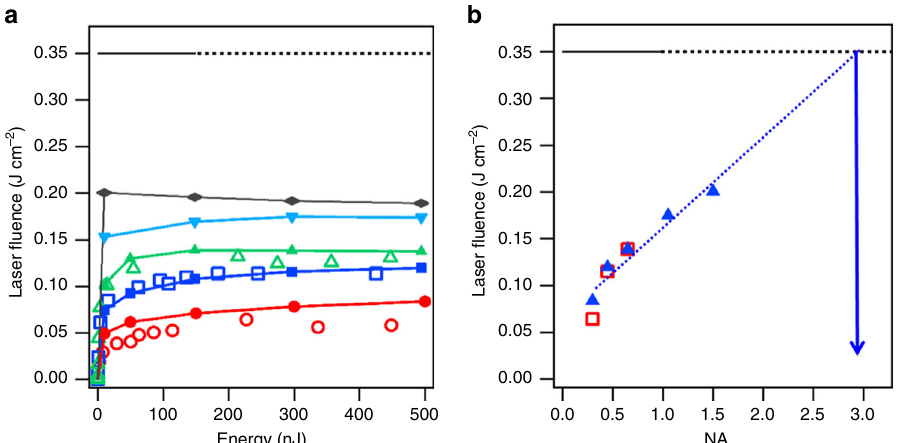
Fig. 2 Maximum delivered laser fl uences inside silicon with ultrashort pulses. Measurements ( hollow symbols ) and simulations ( solid symbols ) for evaluating the peak fl uence delivered with 60-fs laser pulses focused at a depth of 1 mm inside silicon. a Dependence on the incoming laser pulse energy evaluated for increasing numerical apertures (NA): NA = 0.3 ( red ), NA = 0.45 ( dark blue ), NA = 0.65 ( green ), NA = 1 ( light blue ), and NA = 1.5 ( gray ). b Fluence saturation levels plotted as a function of NA. Taken as a target, the dark horizontal line is the measured threshold for modi fi cation with the same laser beam at the surface of the sample. The blue arrow indicates by extrapolation that a NA near 3 is required to cross this fl uence threshold in the